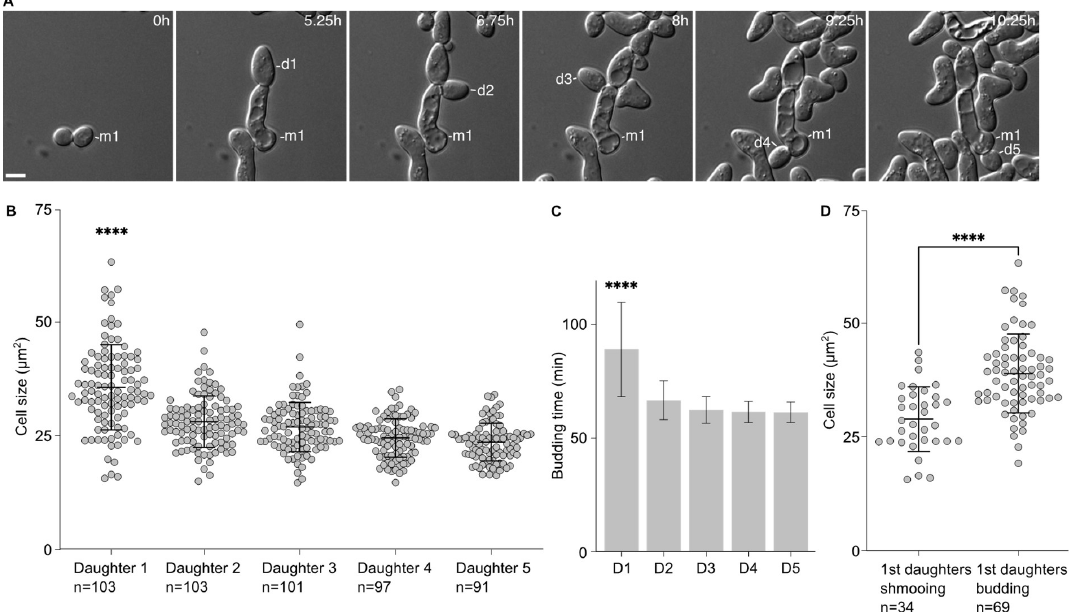
Figure 1. The first daughter cells are larger than the subsequent ones after escape. ( A ) Escape of a WT cell exposed to 7 nM of pheromone. M1 = mother cell. D# = daughter cells of the escaped mother cell. Scale bar = 5 µm. ( B ) Cell size (area; average ± SD) in µm 2 of the 1st and subsequent daughter cells. The variable n = number of cells obtained from 3 independent experiments. The **** = p value < 0.0001 obtained from an ordinary one-way ANOVA comparing the cell size of the 1st daughter to the size of any of the subsequent daughter cells. ( C ) Time for each daughter cell from bud emergence from the mother cell to cell separation (average ±SD). The **** = p value < 0.0001 obtained from an ordinary one-way ANOVA comparing the timing of the 1st daughter to the timing of any of the subsequent daughter cells. The variable n as in A. ( D ) Cell size (area; average ± SD) in µm 2 of the 1st daughter cells that are either shmooing or budding upon birth. The variable n = number of cells obtained from 3 independent experiments. The **** = p value < 0.0001 obtained from an unpaired two-tailed t -test.